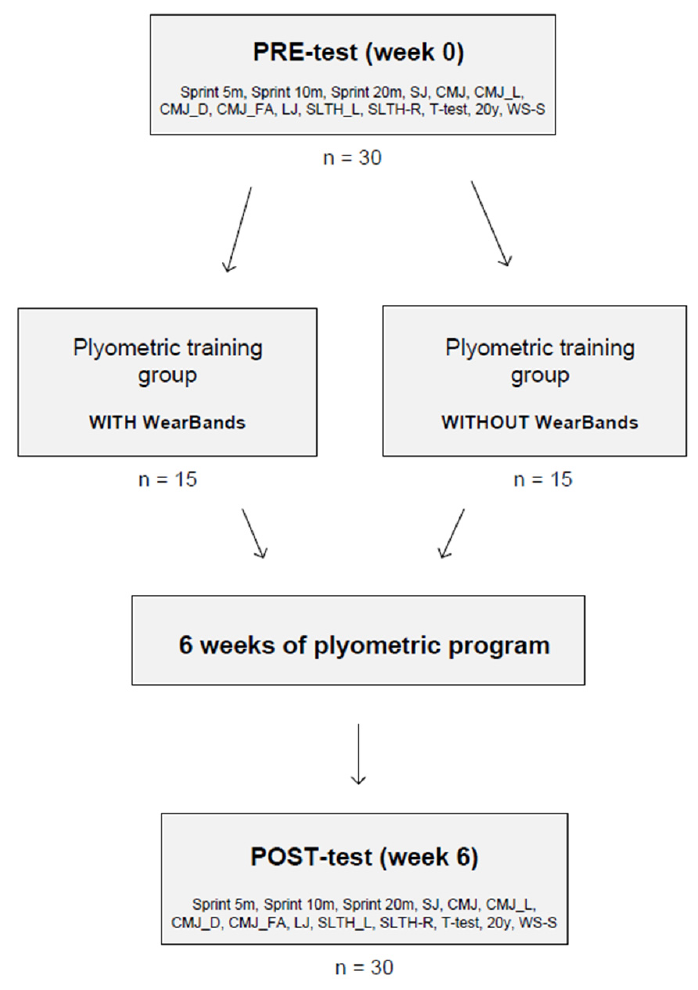
Figure 1. Mind Mapping for the research procedure.